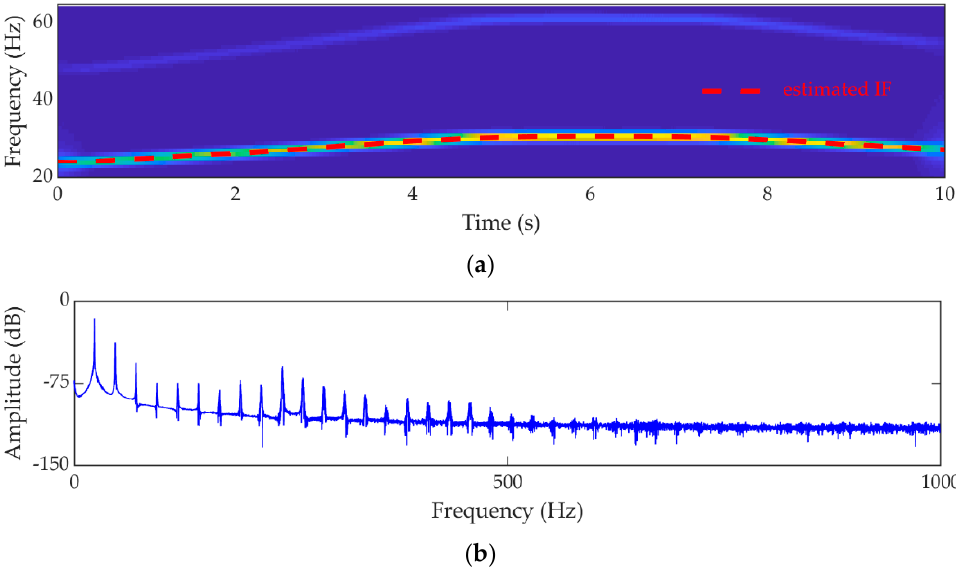
Figure 12. ( a ) The estimated IF of the separated fundamental harmonic component by the iteration procedure compared with the TFR generated by STFT; ( b ) the amplitude spectrum of the signal after resampling.